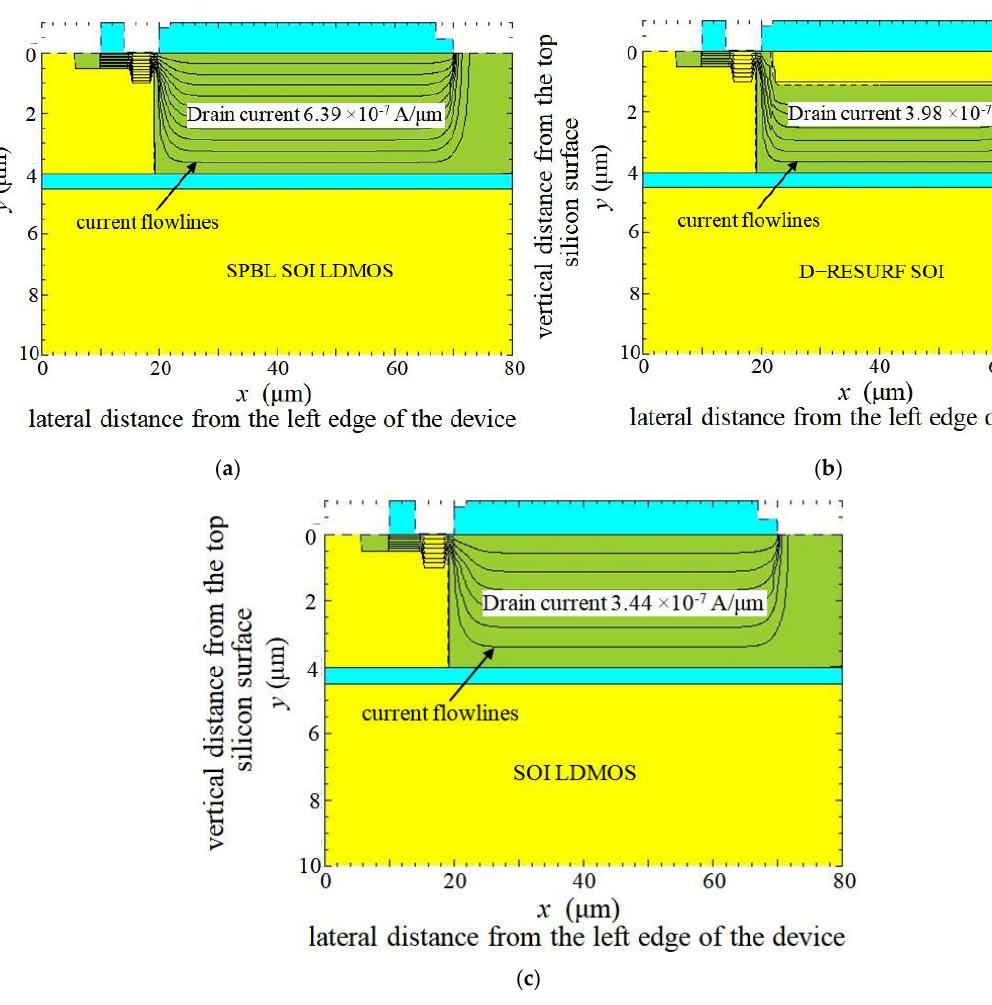
Figure 4. Current distributions in the drift region of ( a ) SPBL SOI LDMOS, ( b ) D − RESURF SOI LDMOS, and ( c ) SOI LDMOS at V g = 15 V and V d = 0.1 V.